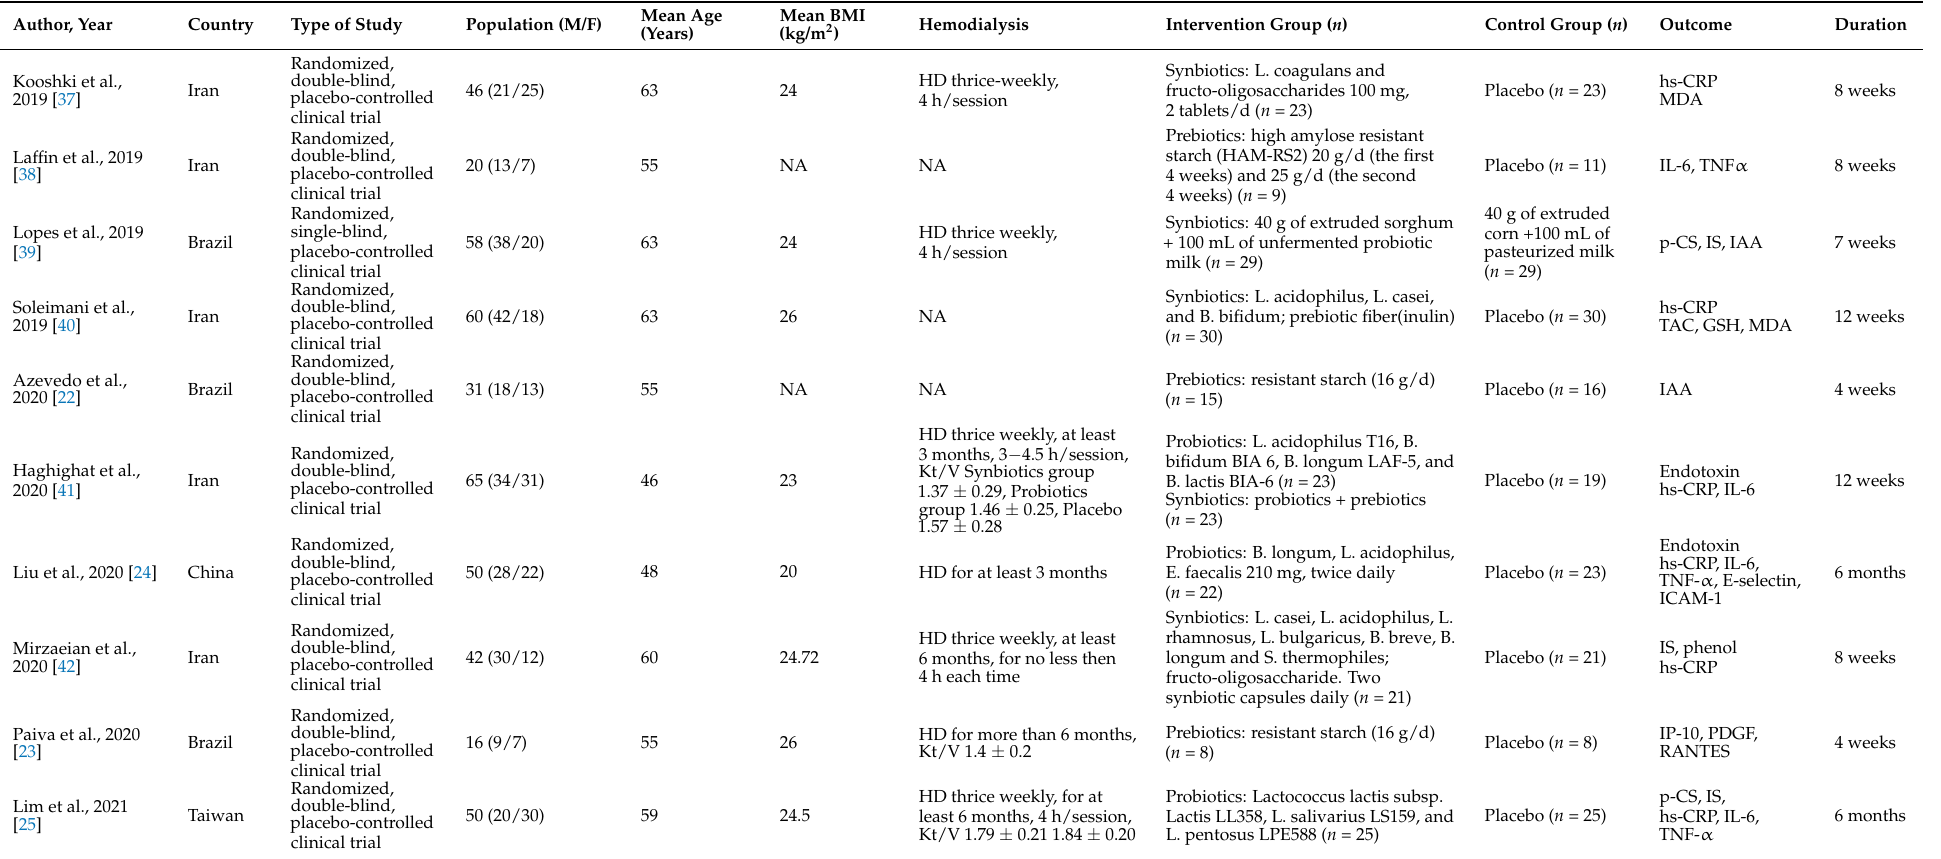
L. pentosus LPE588 ( n =